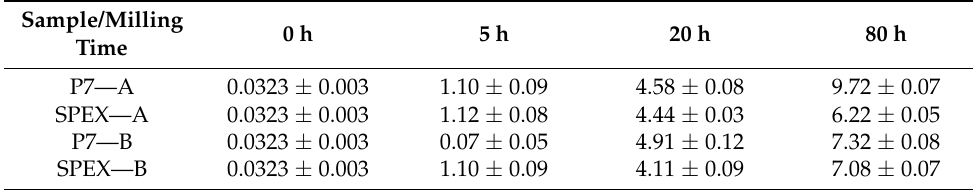
Table 4. Dislocations density, ρ (10 15 m − 2 ), of the cubic bcc Fe main phase. Sample/Milling